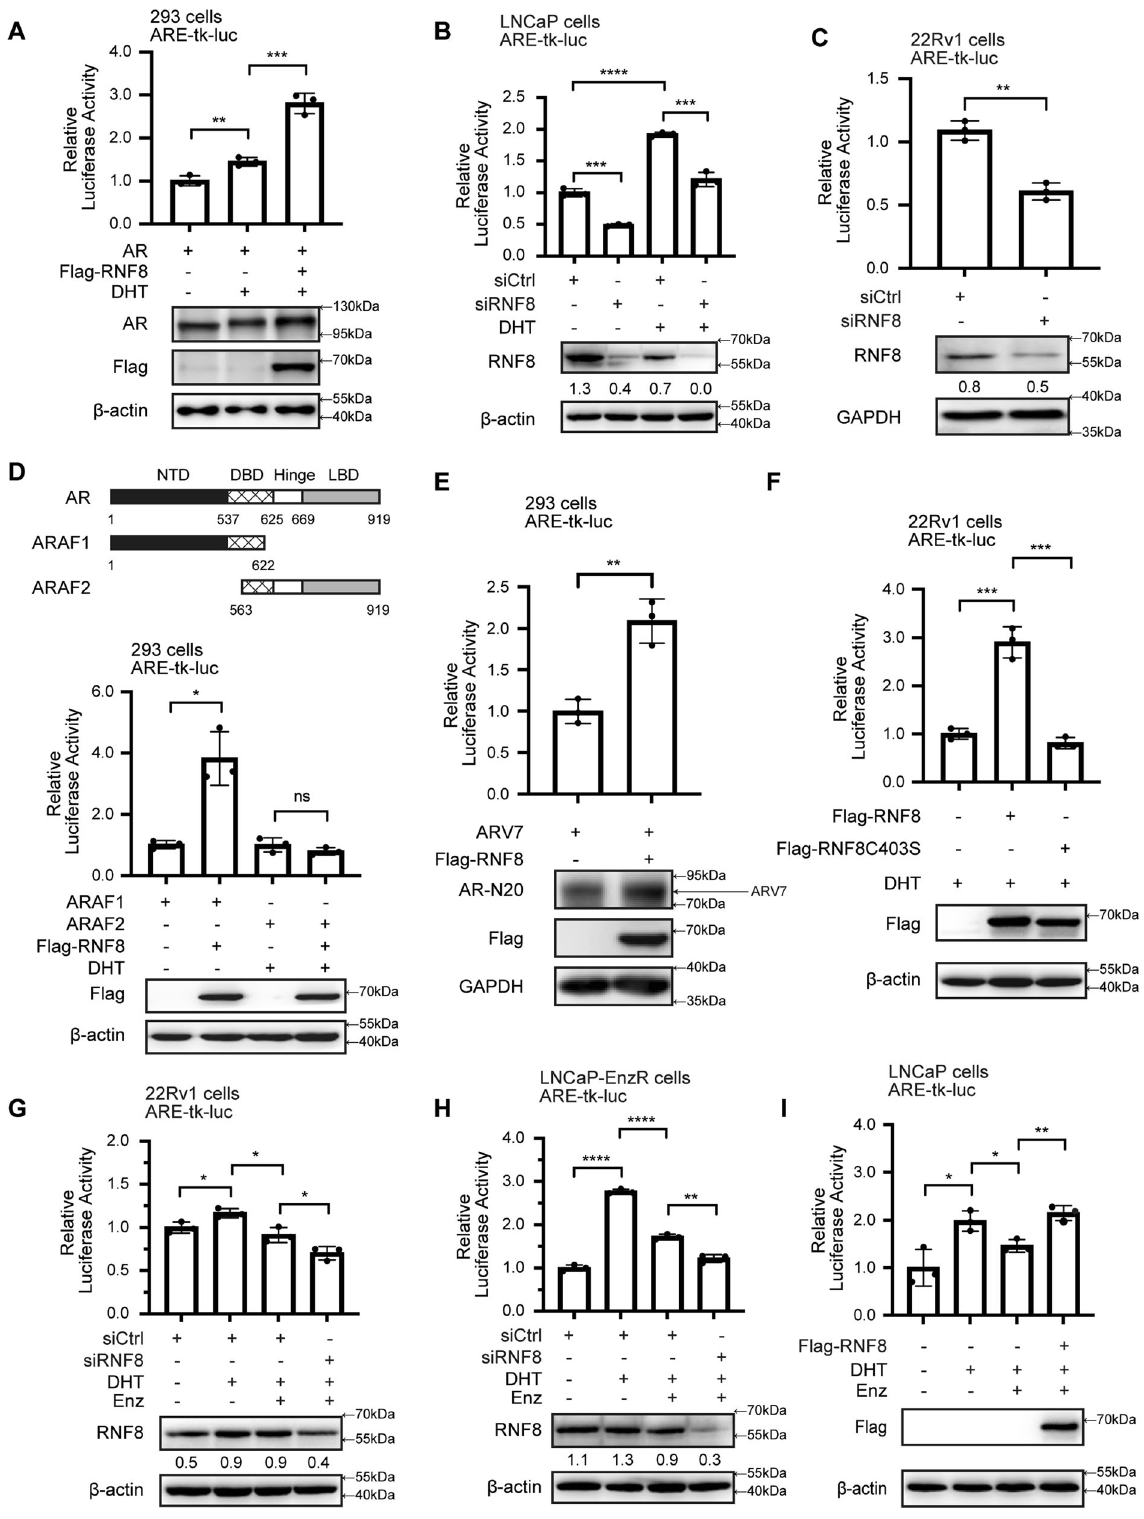
trend of higher RNF8 expression with higher GS in human PC tissues (Fig. 1C, D and Supplementary Table 2). RNF8 expression is high in AR-positive PC and CRPC cells (Fig. 1E), consistent with bioinformatics analyses in PC (Fig. 1F, G). Furthermore, RNF8 mRNA expression is positively correlated with AR in PC (Fig. 1H).